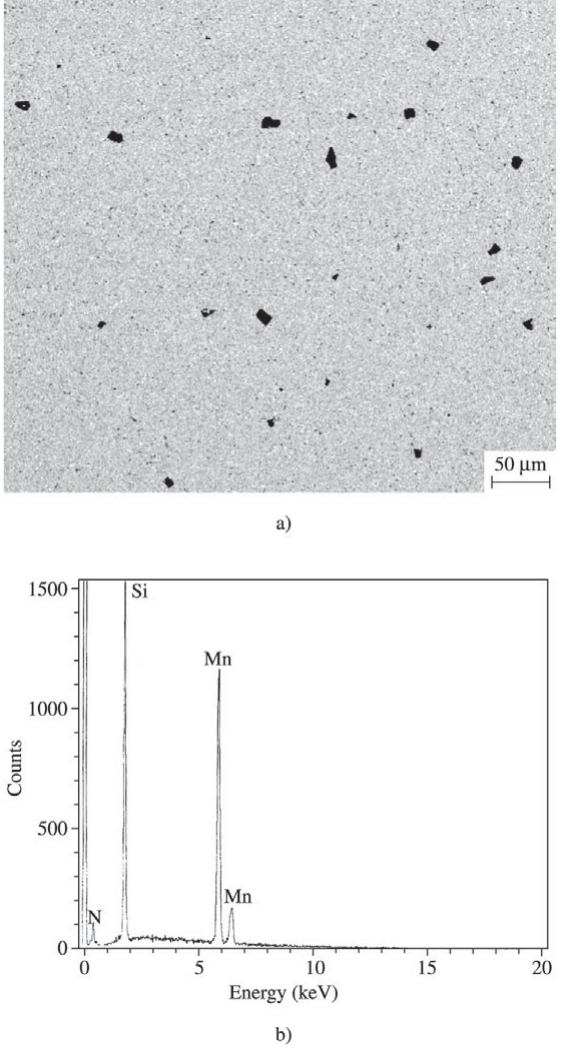
Figure 5. Detail of the internal precipitation of the G11 steel sam- ple at 650 °C in the real condition. a) SEM micrography illustrat- ing the morphology of the precipitates; b) EDS spectrum of the precipitates.